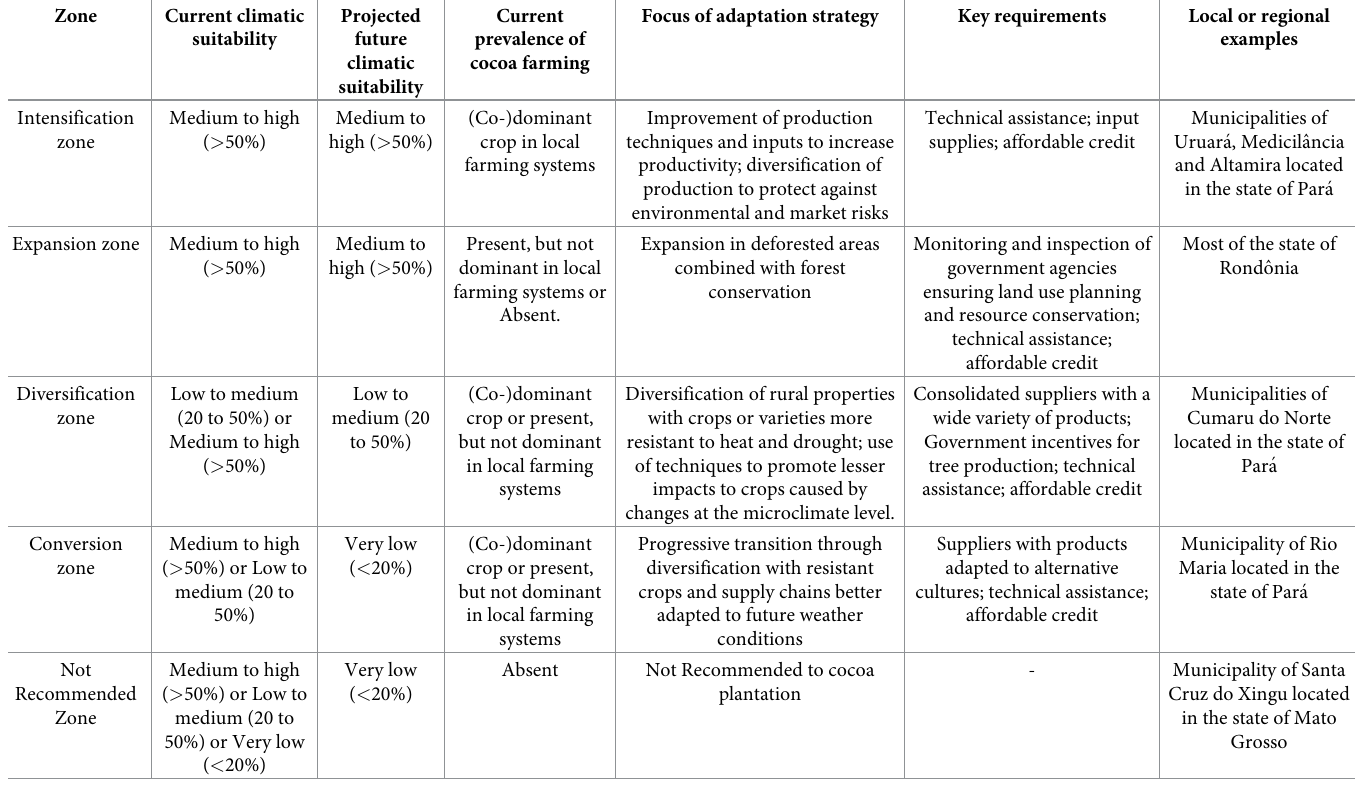
Table 1. Schematic zoning of the Brazilian Amazon